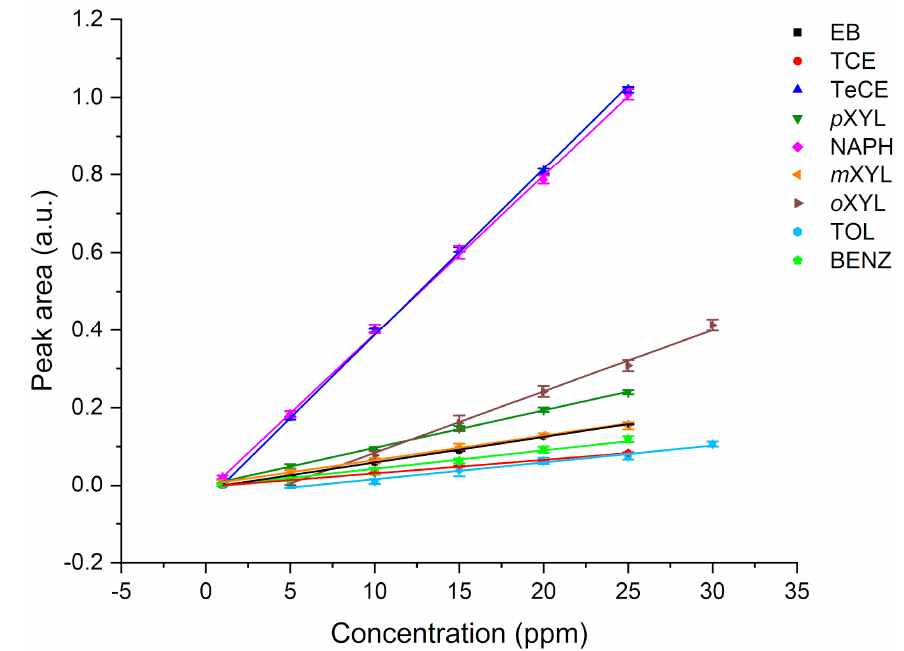
Table 3. Overview of the calibration functions established from evaluating the peak area at equilibrium conditions with the evaluated wavenumber, linear fit function, and 𝑟² -value of the respective analyte.